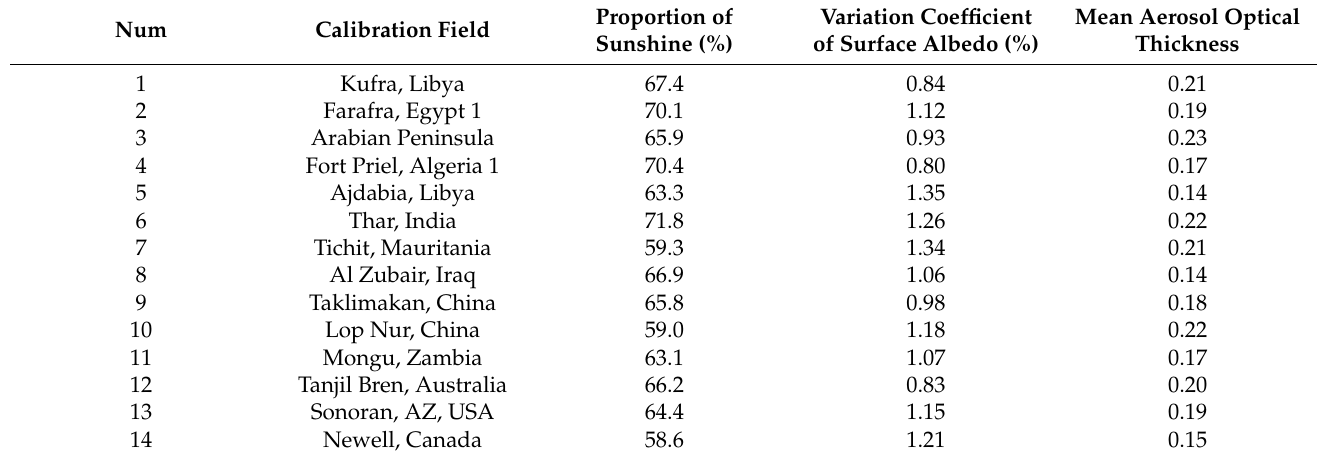
Table 4. Statistics on the evaluation parameters of the GMI calibration field in 2018.